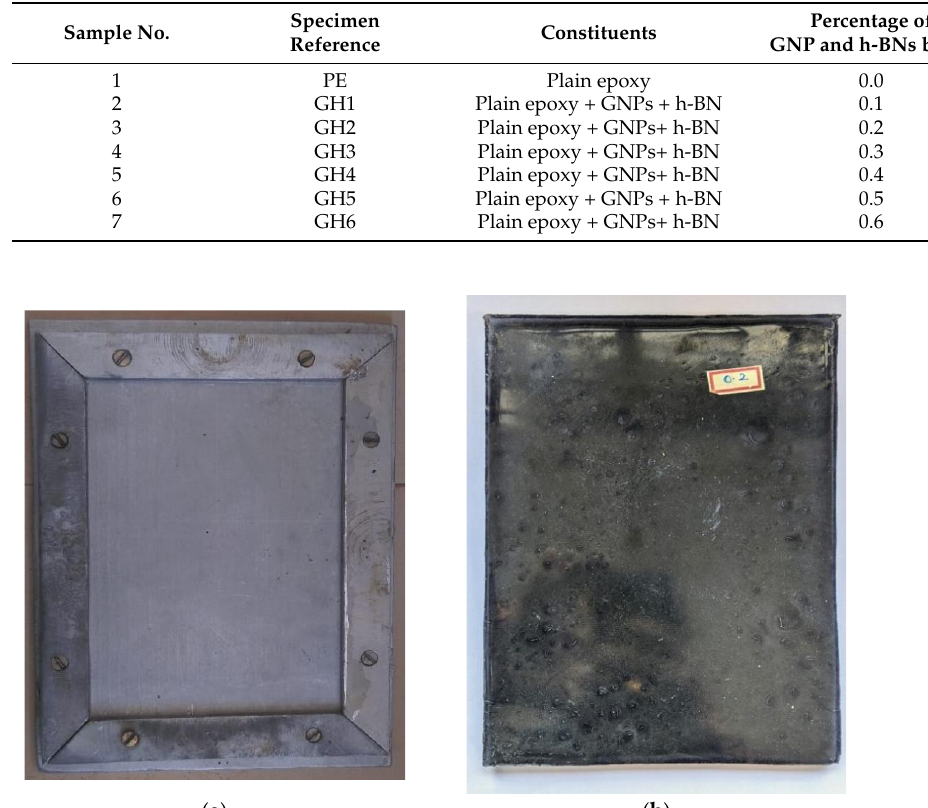
Table 3. Test specimen details (GNP and h-BN).